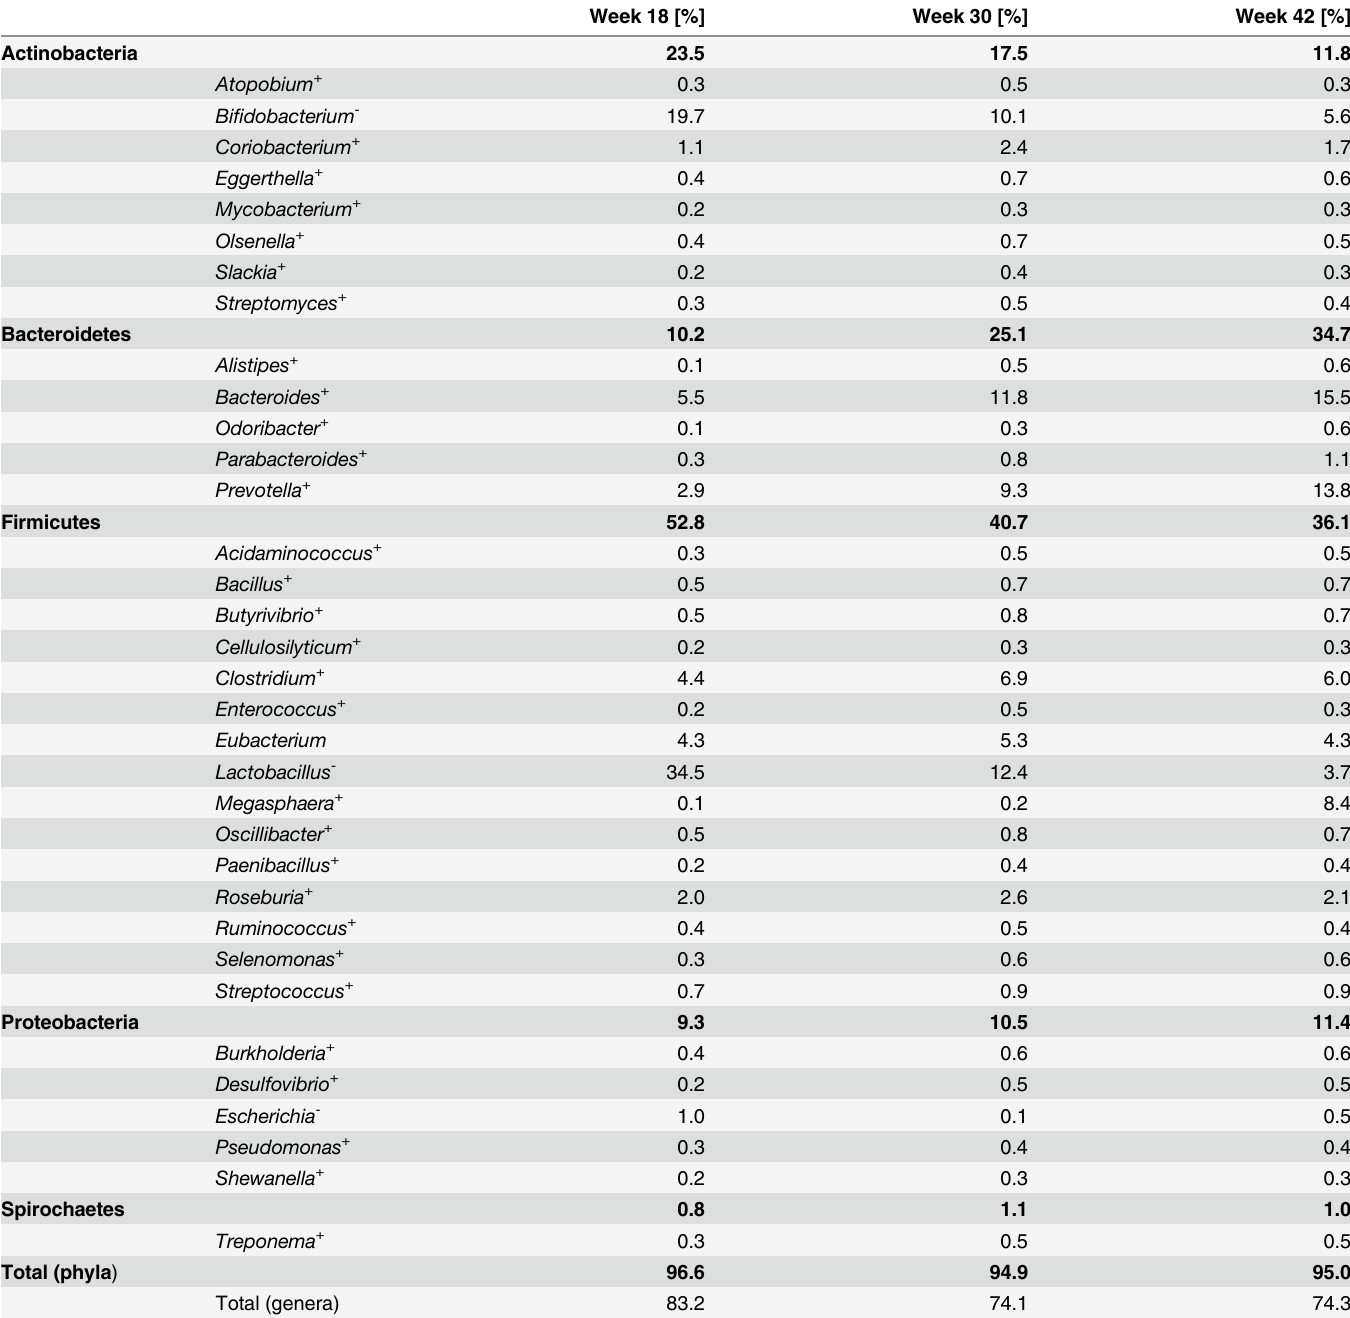
Table 2. Average percentages of most abundant genera and phyla.